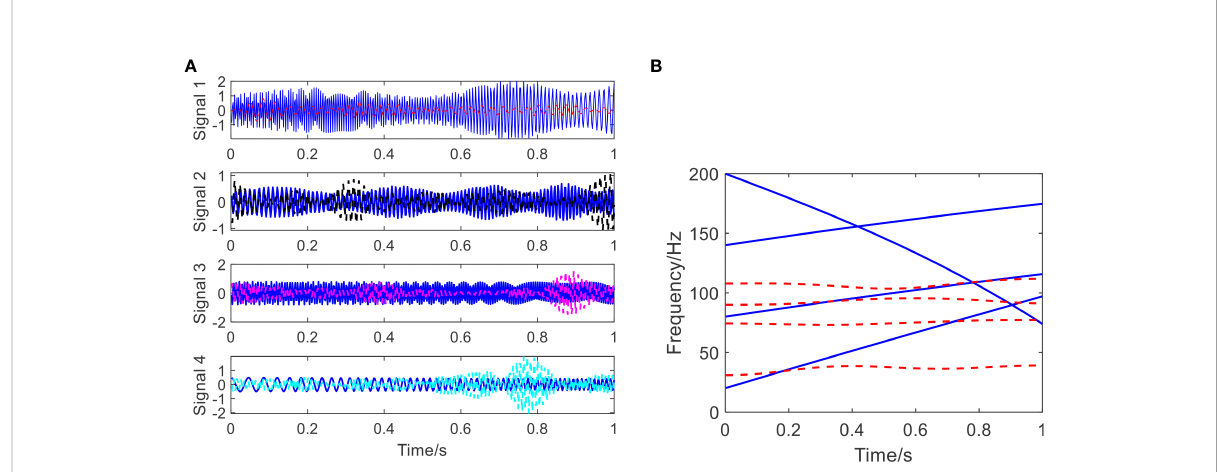
FIGURE 5 The estimated signal components and estimated time frequency plot using the VNCMD method. (A) The estimated components (blue: true; red, black, carmine and cyan: estimated ones); (B) the estimated time frequency plot (blue: true; red: